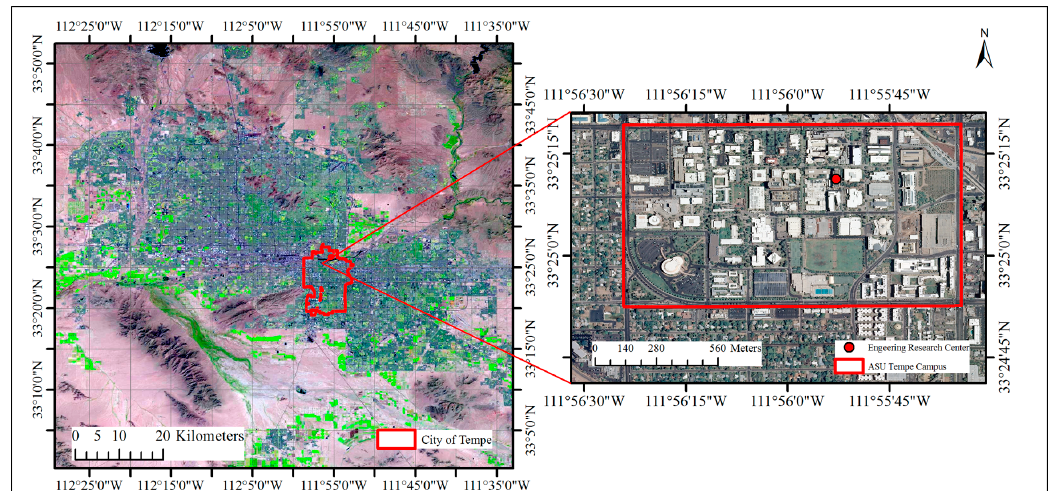
Figure 1. Study area. Table 1. Weather conditions during the experimental period.